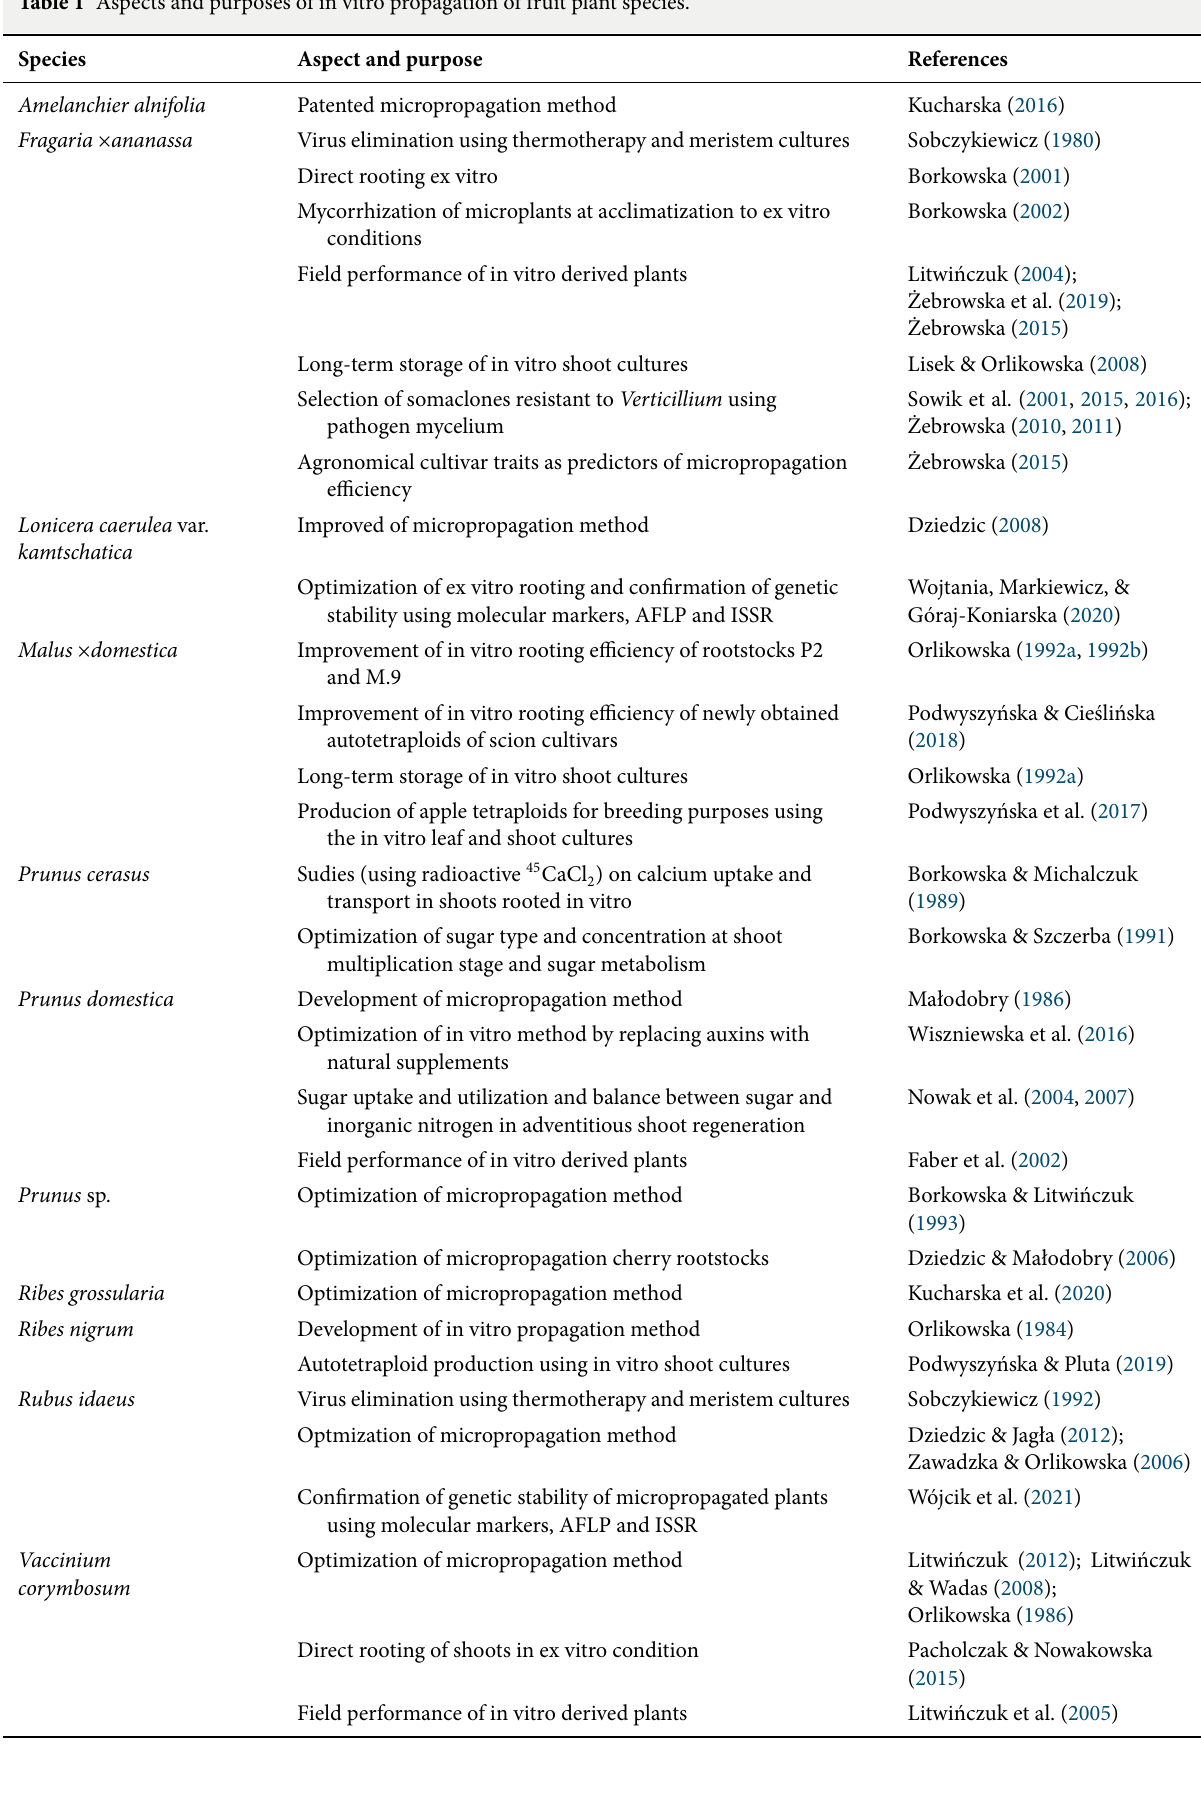
Table 1 Aspects and purposes of in vitro propagation of fruit plant